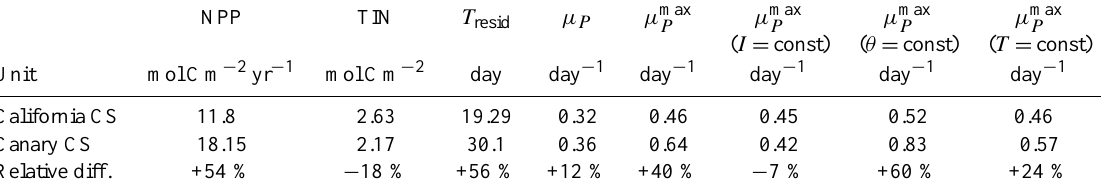
Table 3. Production and its drivers averaged over the 300km wide nearshore area for the California CS and the Canary CS. T resid refers to the water residence time in the 100km wide nearshore area. µ P and µ max refer to the growth rate and nutrient-replete growth rate, respectively. P